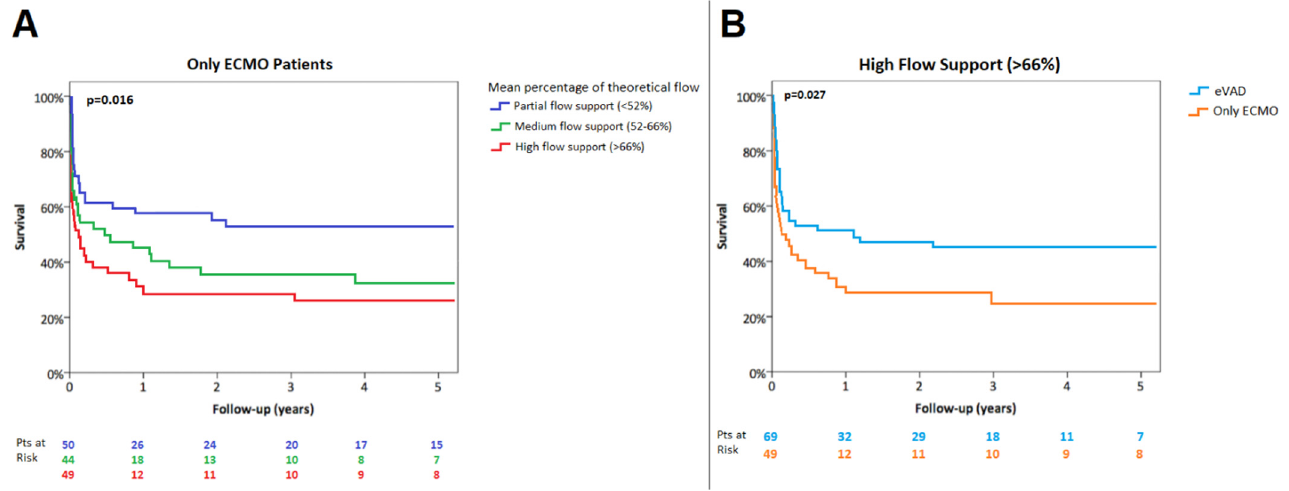
Figure 3. Kaplan–Meier survival according to ECMO flow support ( A ) and with high-flow ECLS configuration ( B